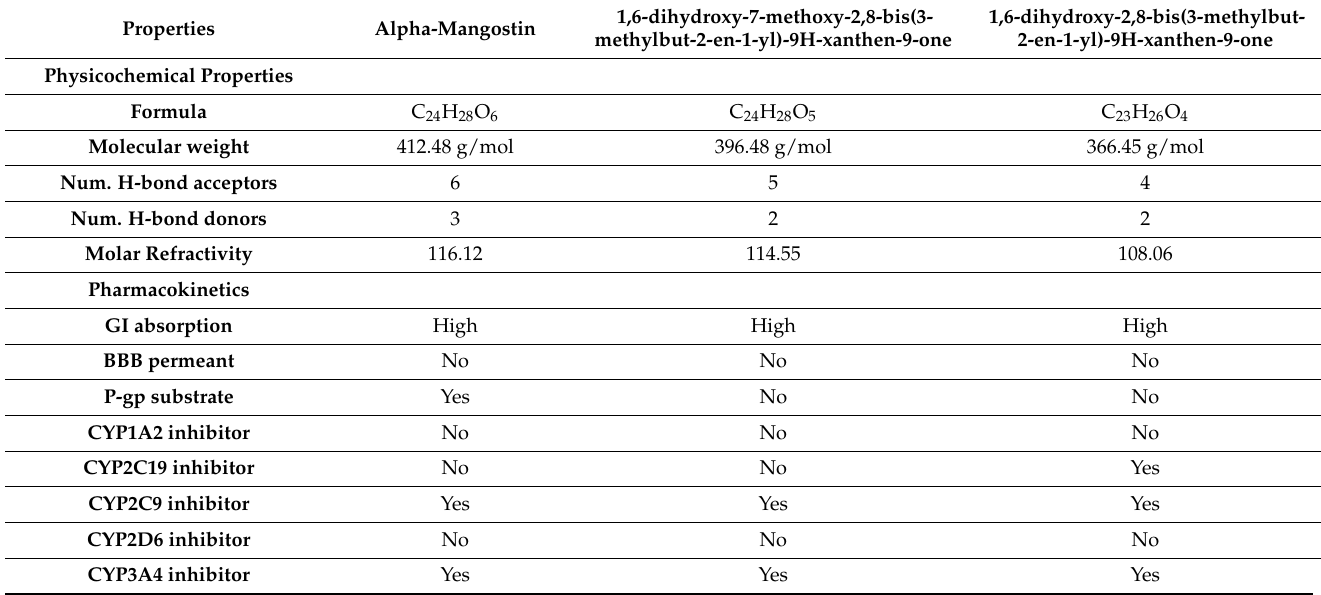
Table 4. Physicochemical and Pharmacokinetics of